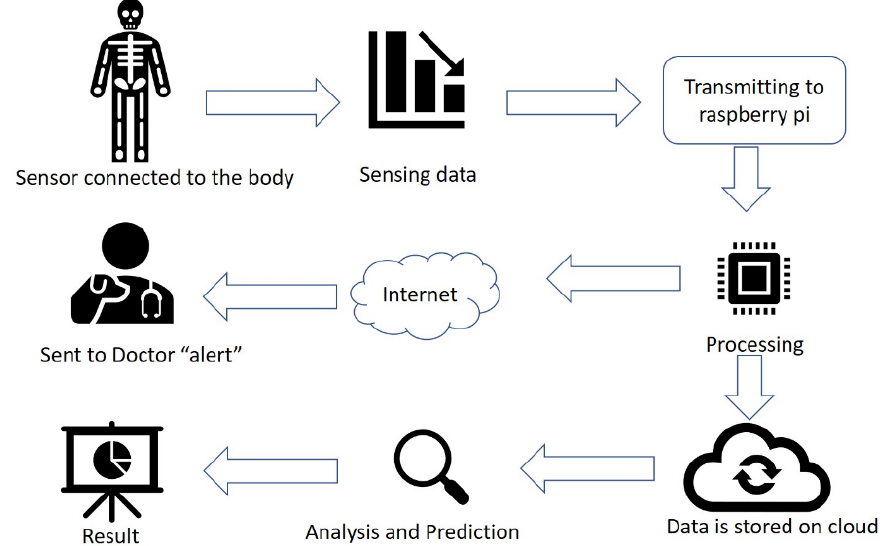
Figure 1. Block diagram of Internet of Things (IoT) system [21].